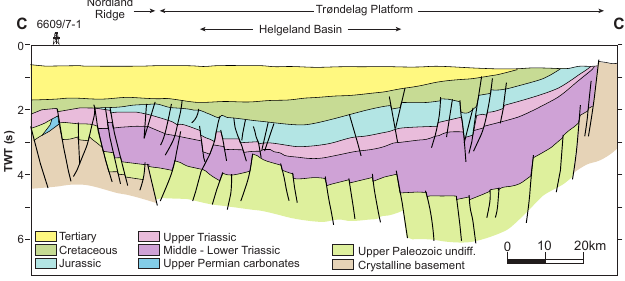
Figure 9. Geoseismic profile shows the northern part of the deep Permo–Triassic basin area off- shore central-northern Norway. From Blystad et al. (1995). Location of profile in Fig. 8. Well, 6609/7-1 that encountered Upper Permian carbonates above basement is projected onto the profile.